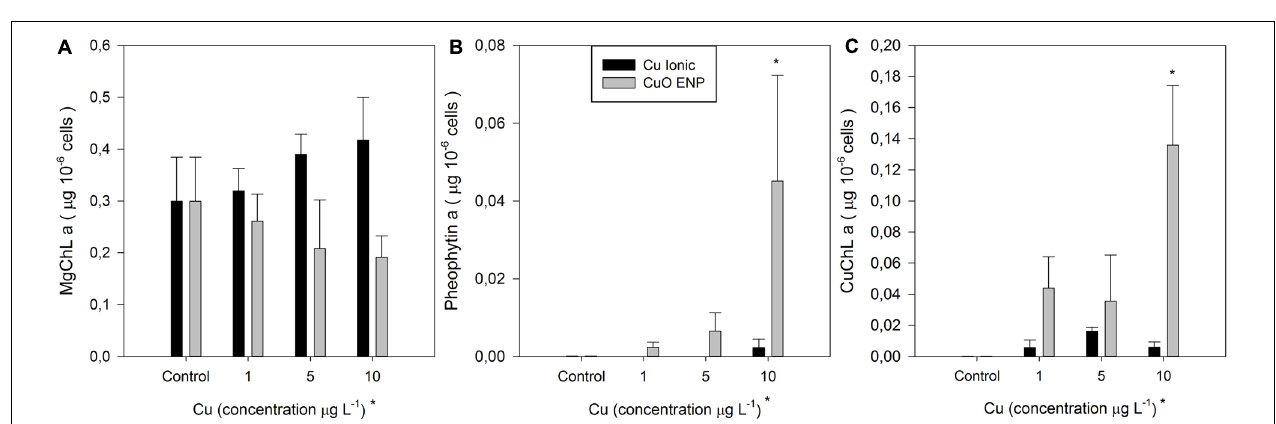
FIGURE 5 | Phenomenological energy fluxes per cross-section: absorbed (ABS/CS), trapped (TR/CS), transported (ET/CS), dissipated (DI/CS), and number of available reaction centers per cross section (RC/CS), in P. tricornutum after 3 days of exposure to increasing ionic Cu (A) and CuO ENP (B) (gray bars) concentrations (average ± standard deviation, N = 3, *indicate significant differences compared with the control at p < 0.05).